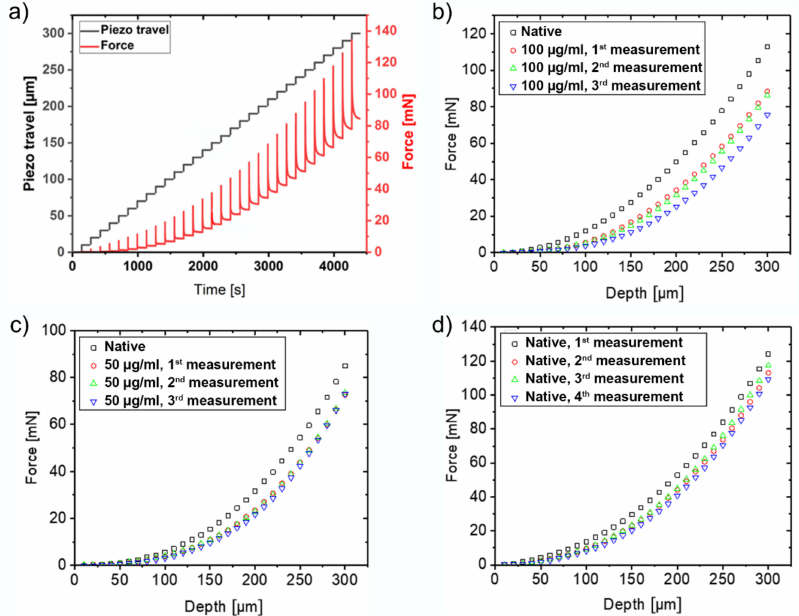
Figure 2. ( a ) Piezo travel (black line) and stress-relaxation curve (red line) as a function of time for a native cartilage sample. It is particularly evident that the initial non-linear part of the indentation curve (toe region) becomes linear with depth. The next graphs show the indentation curves for ( b ) a sample treated with 100 µ g / mL concentration of collagenase, ( c ) a sample treated with 50 µ g / mL collagenase and ( d ) an untreated